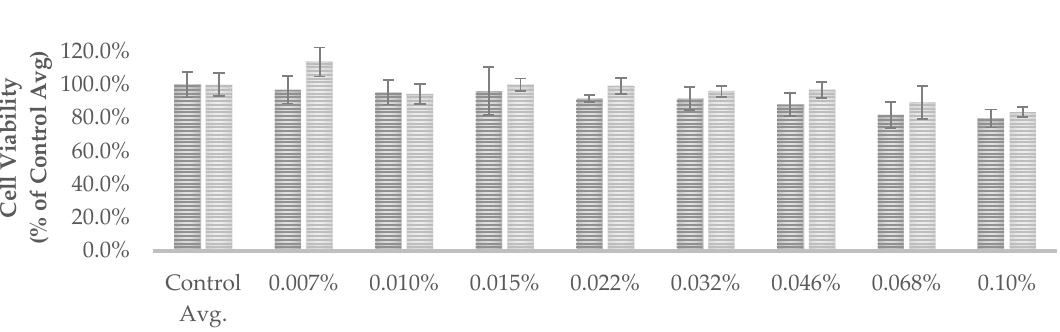
Figure 2. Pomegranate results. Cell viability by concentration of Pomegranate WCD cleansing conditioner, stratified by with and without solar simulated light (SSL).